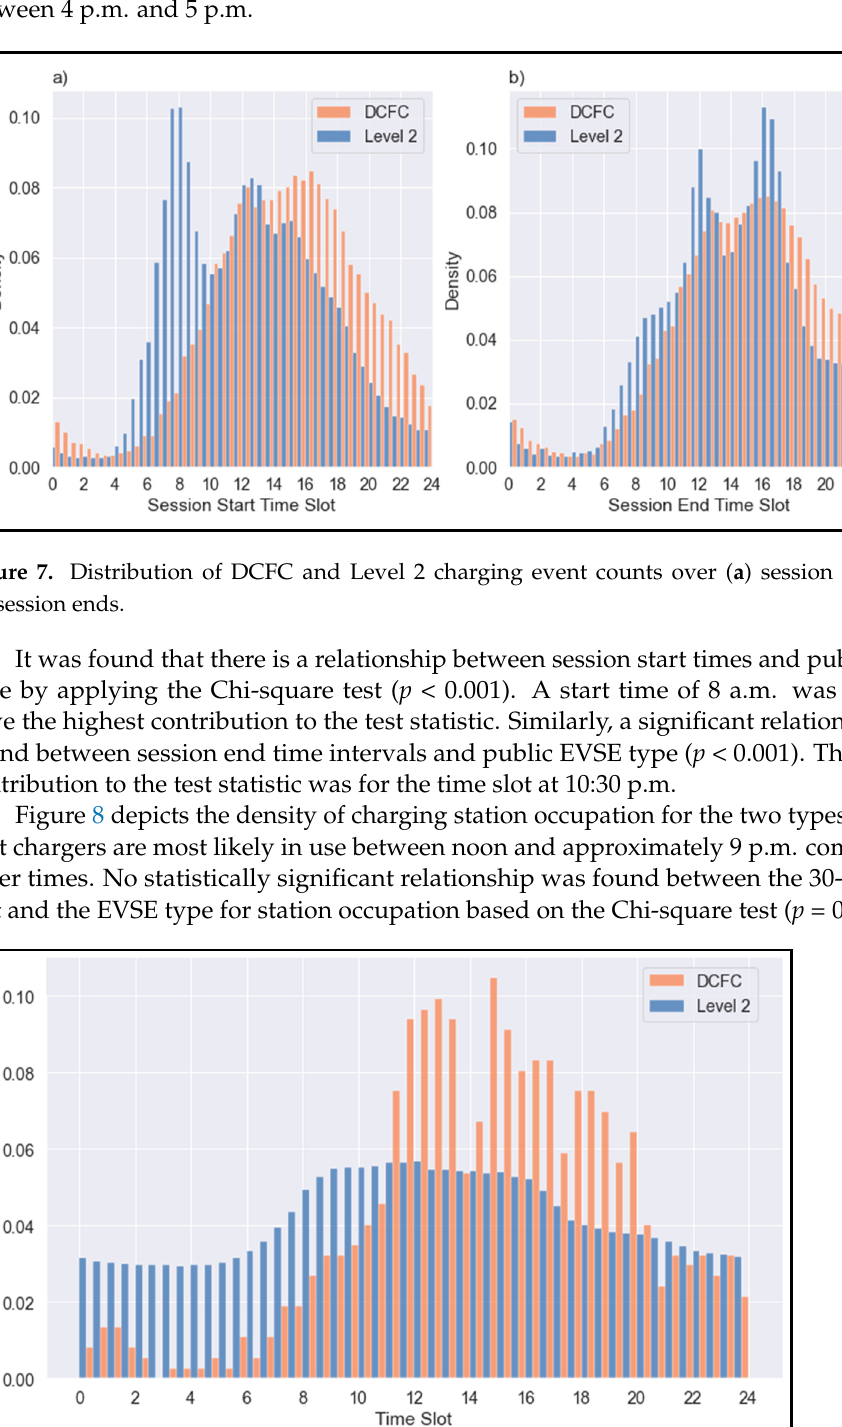
Figure 9. Distribution of DCFC and Level 2 charging event counts over day of the week. A trend analysis was conducted for DCFC time series data by day and month for the following variables: session counts, average energy consumption, average charging dura- tion, and average charging frequency. Similar to public Level 2 data, the Dickey-Fuller test statistic did not suggest stationarity for any of the variables in the DCFC data over time by day and month. In other words, on a daily and monthly basis, the utilization of DCFC utilization seems to follow a positive trend over time in the number of sessions (autocorrelation for months: p = 0.54, autocorrelation for days: p = 0.53), average energy consumption, ( p = 0.98, p = 0.64), mean charging duration ( p = 0.75, p = 0.85), and average charging frequency ( p = 0.25, p = 0.23). A seasonality analysis using temporal autocorrelation resulted in differences be- tween public DCFC and Level 2 patterns over time. The DCFC mean duration by month showed the highest correlation with a time lag of 12 months (0.91), showing the same pattern as public level 2 charging. Differences in monthly patterns between the two EVSE types were found for session counts (0.90), mean energy consumption (0.97), and mean frequency (0.84), where the utilization of two consecutive months correlated the most. This indicates that the utilization of DCFC stations for these variables can be predicted most accurately based on the utilization of the previous months. The seasonality of session counts for both types of EVSE is depicted in Figure 10. When looking at the daily